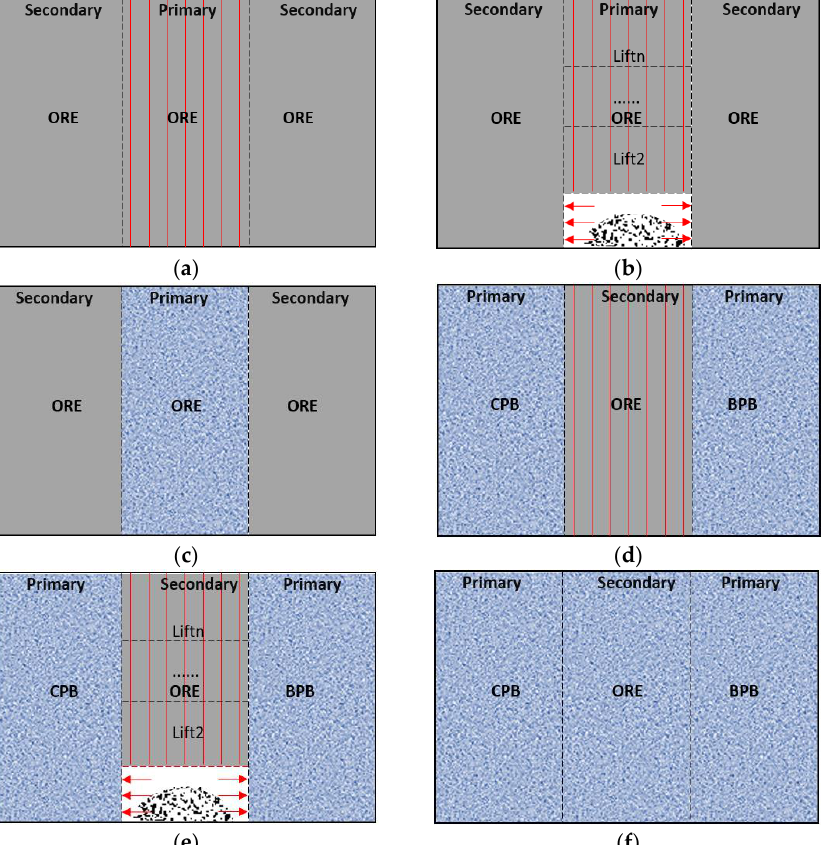
Figure 1. Stope mining and backfill sequence. ( a ) Primary stopes planed; ( b ) Primary stope layer blast; ( c ) Primary stope backfill; ( d ) Secondary stopes planed; ( e ) Secondary stope layer blast; ( f ) Secondary stope backfill.